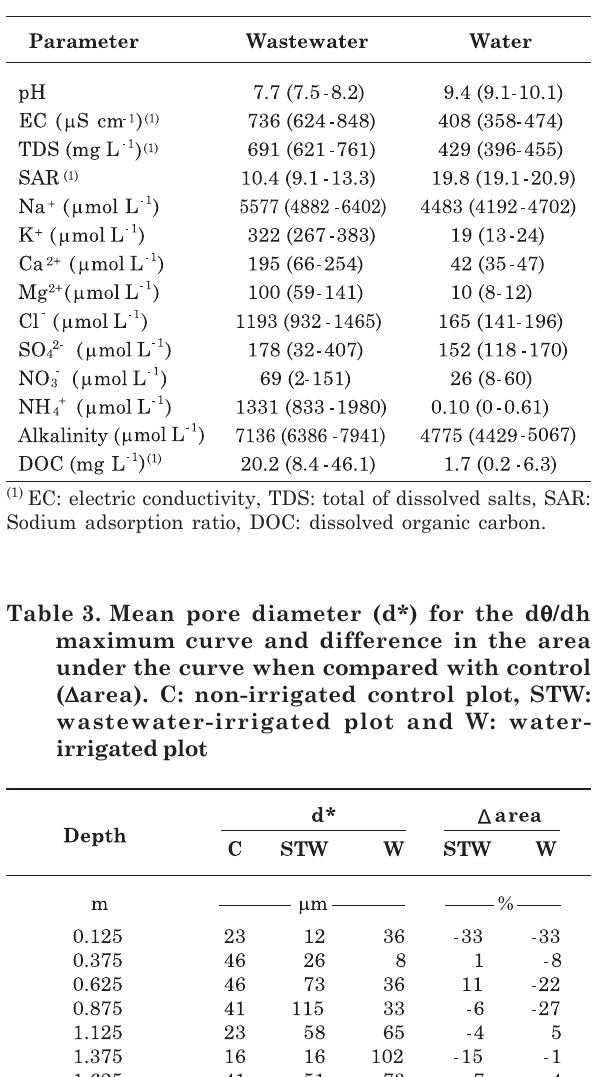
Table 2. Chemical composition of secondary-treated wastewater and of treated groundwater in Lins, São Paulo. Mean values followed by minimal and maximal values in brackets